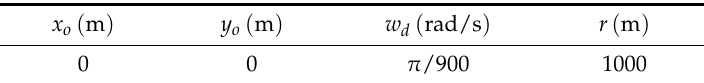
Table 5. Circular-trajectory parameters.